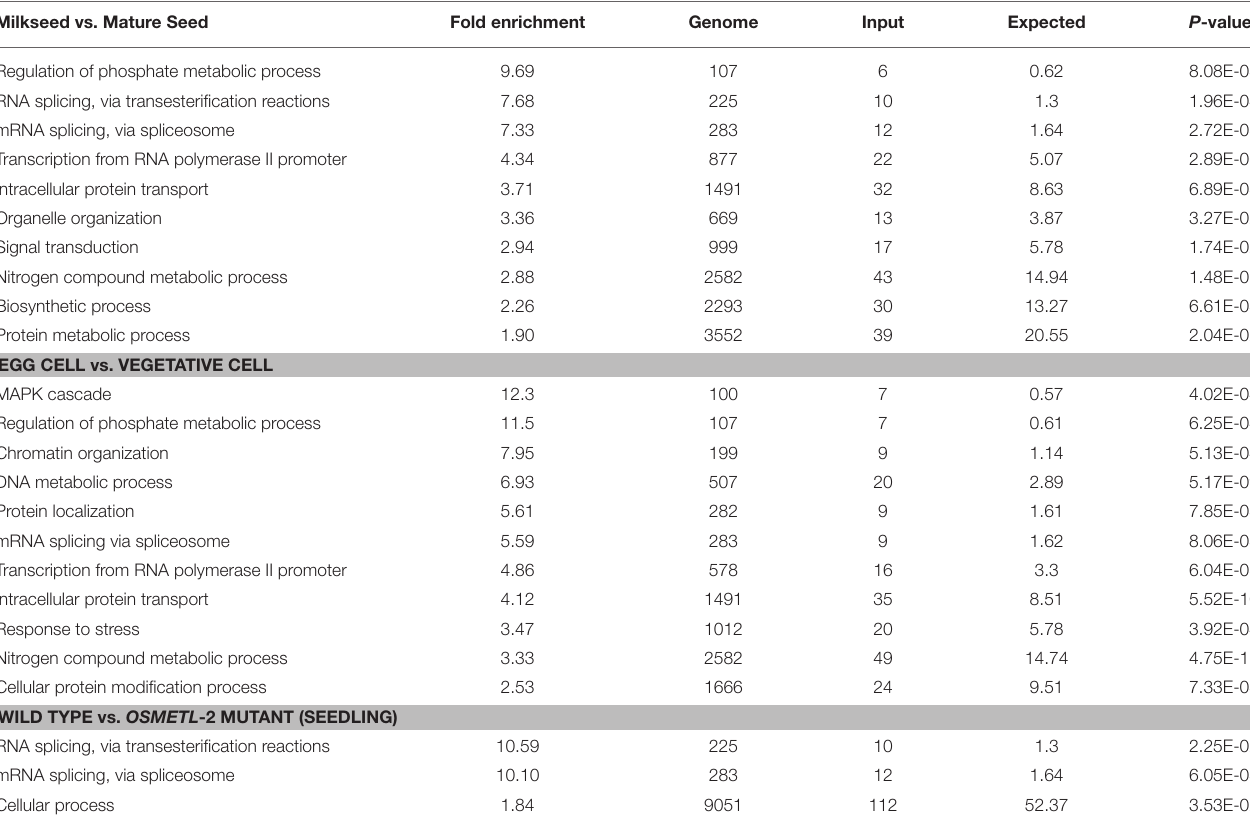
TABLE 1 | Gene Ontology statistical enrichment based on predicted alternative splicing events from developing seeds, reproductive cell types, and OsMet1-2 mutant seedlings with PANTHER overrepresentation test ( p ≤ 0.05). Milkseed vs. Mature